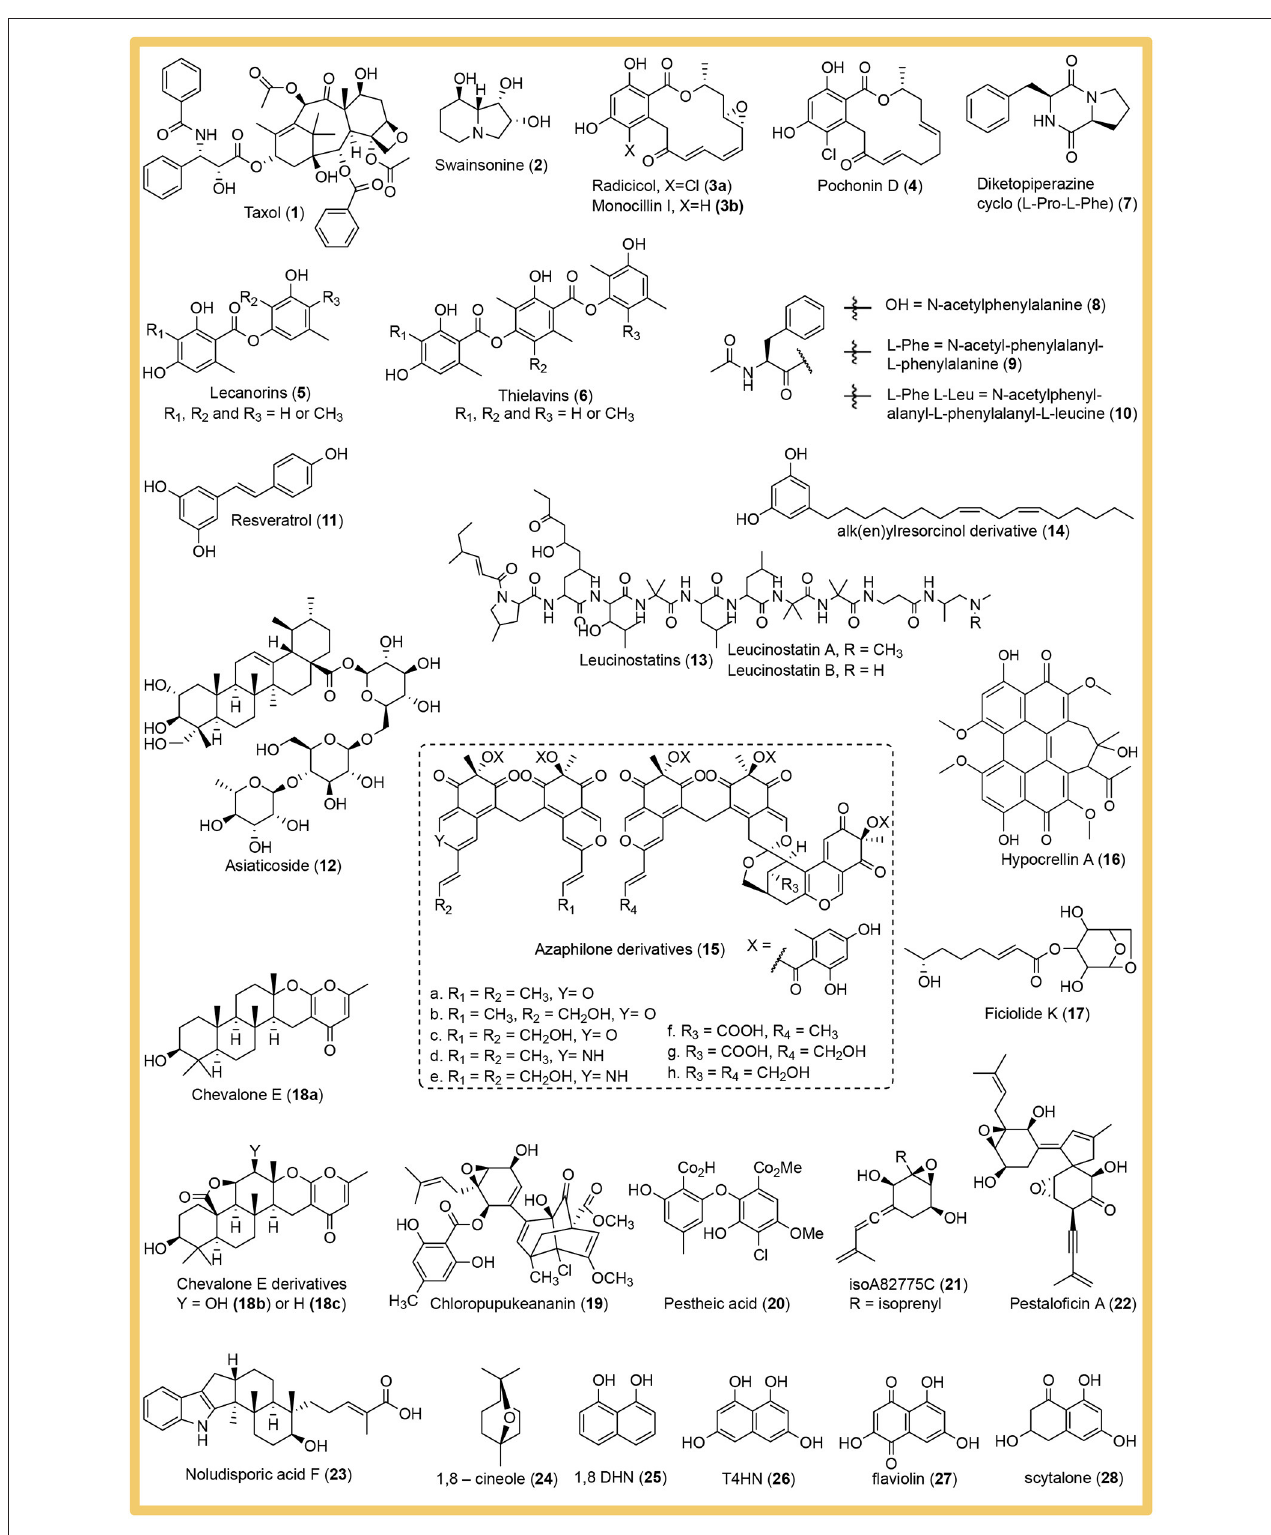
FIGURE 2 | Structures of the bioactive secondary metabolites isolated from endophytic fungi and named in this review.